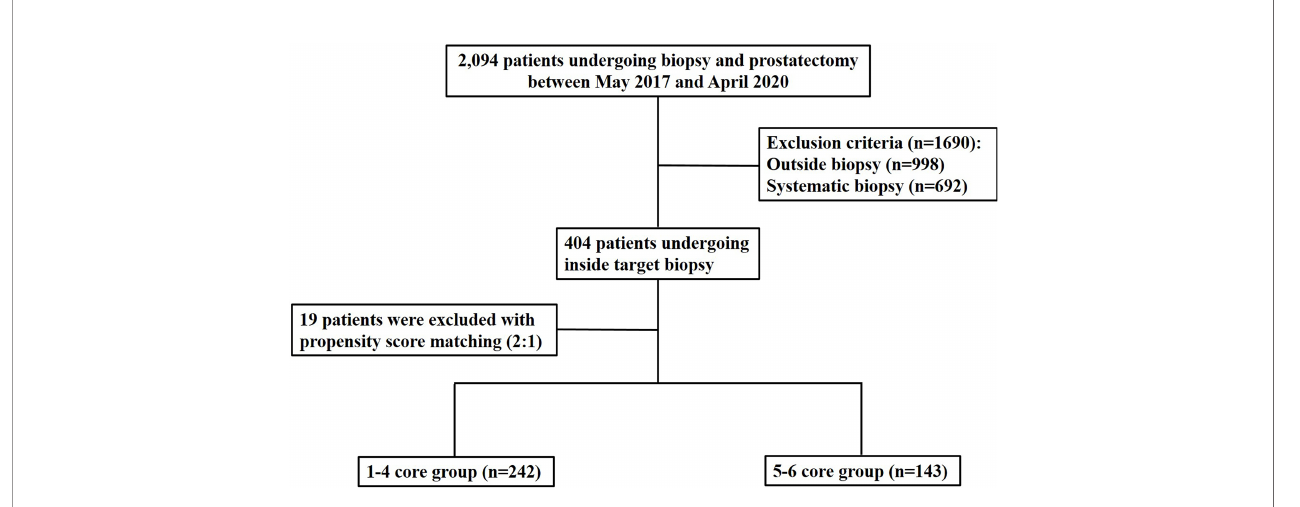
FIGURE 1 | Flow diagram illustrating how to include and to exclude